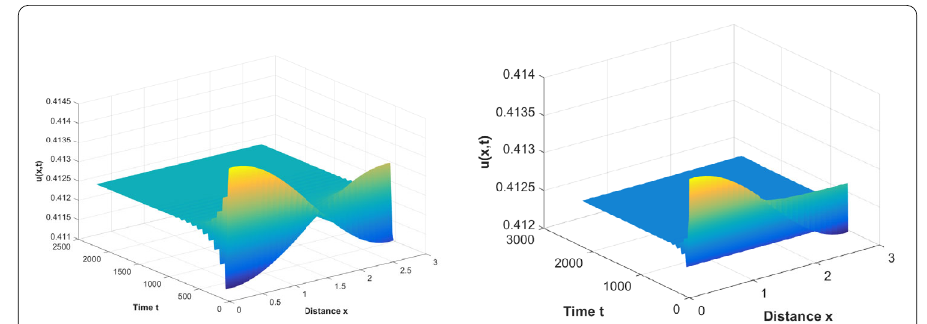
Figure 2 Numerical simulations for prey population with β = 0.18 τ = 22. (Left: model (1.4). Right: model (2.9))